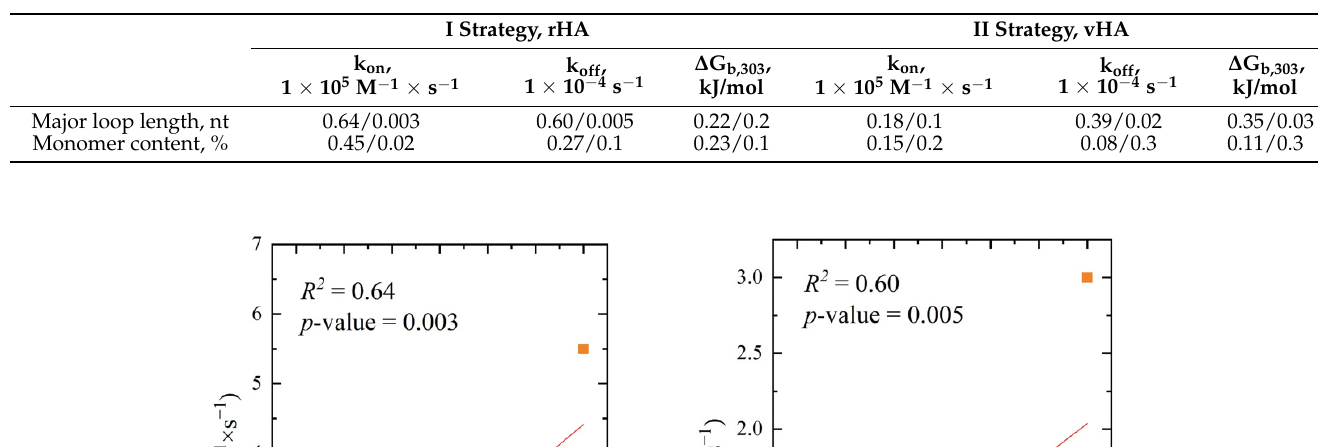
Table 4. Relationships between structural and affinity parameters of RHA0385 variants in terms of coefficient of determina- tion (R 2 ) values and p -values for F-statistics of linear regression (given as follows: R 2 / p -value. These values are given for the dependencies of kinetic constants of association (k on ) and dissociation (k off ), or Gibbs energy of binding ( ∆ G b,303 ) for aptamer complexes with rHA and vHA versus the different structural parameters of aptamers. The strongest correlations with R 2 ≥ 0.6 and p -value ≤ 0.005 are highlighted.